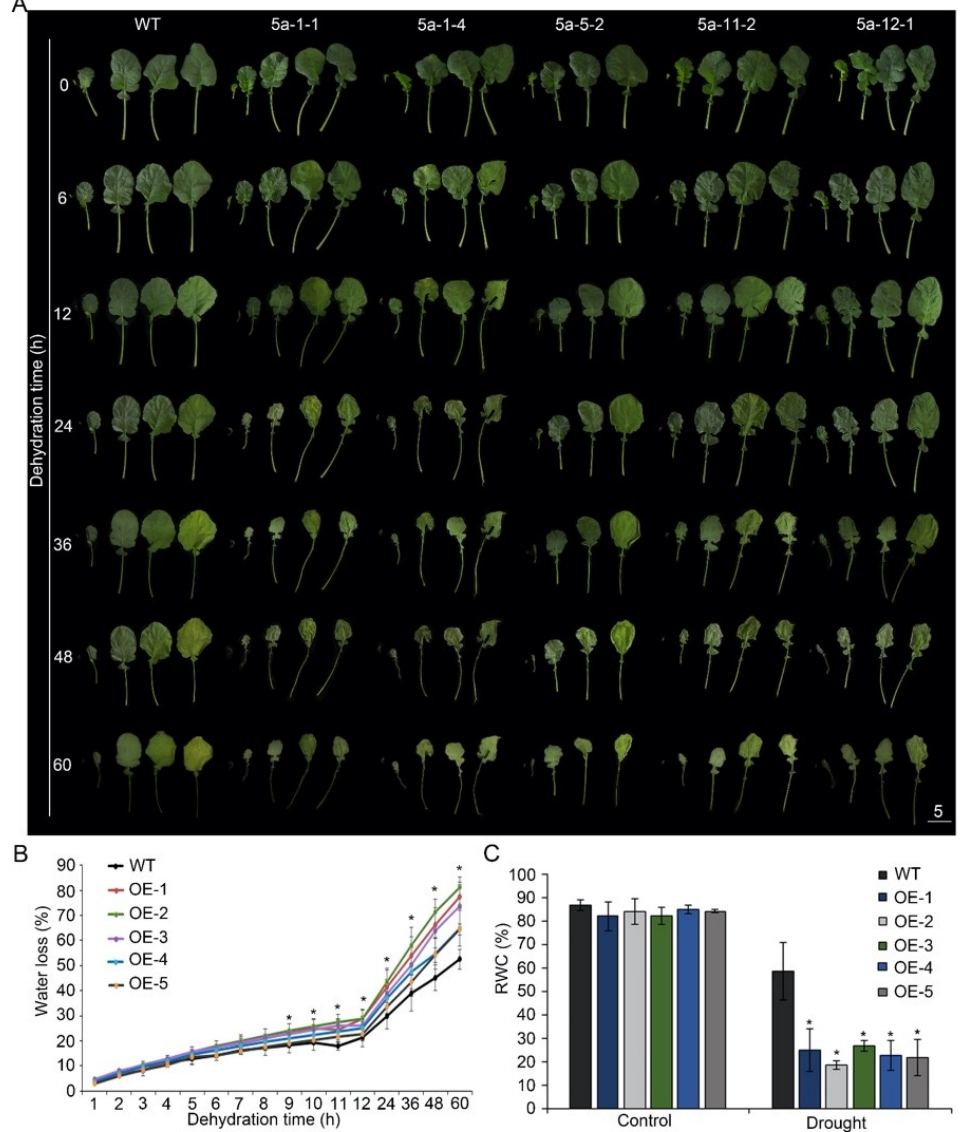
Figure 3. Dehydration test of p35S::BnA.JAZ5 plants at the five-leaf stage. ( A ) Phenotypes of detached leaves of p35S::BnA.JAZ5 plants. ( B ) WLR of five overexpressing lines. Water loss was measured at the indicated time points. Asterisks indicate significant differences between wild-type and p35S::BnA.JAZ5 lines ( p < 0.05, Student’s t -test). ( C ) RWC of five overexpressing lines under drought-stress treatment. Error bars represent standard errors. Asterisks indicate significant differences between control and drought stress ( p < 0.05, Student’s t -test). WT, accession K407. OE-1, OE-2, OE-3, OE-4, OE-5, and p35S::BnA.JAZ5 lines. Scale bar, 5